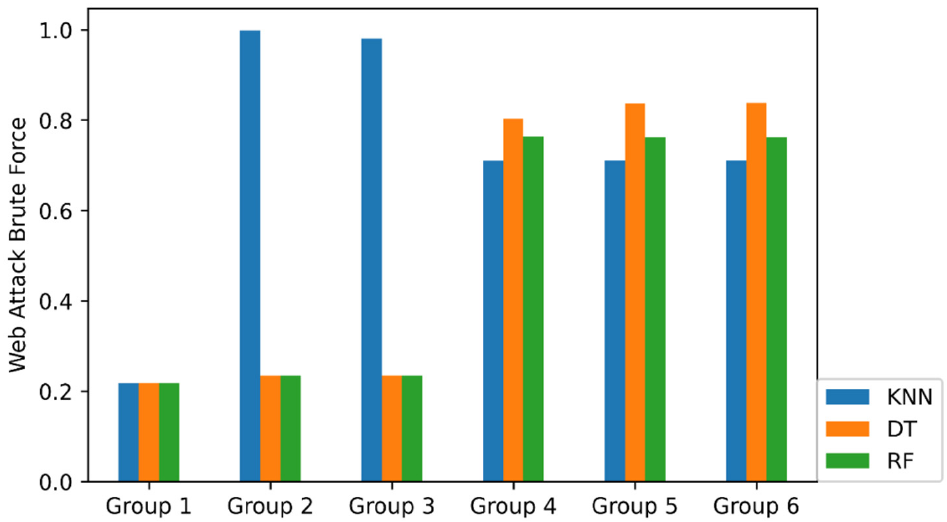
Figure 3. Recall of Web Attack Brute Force.